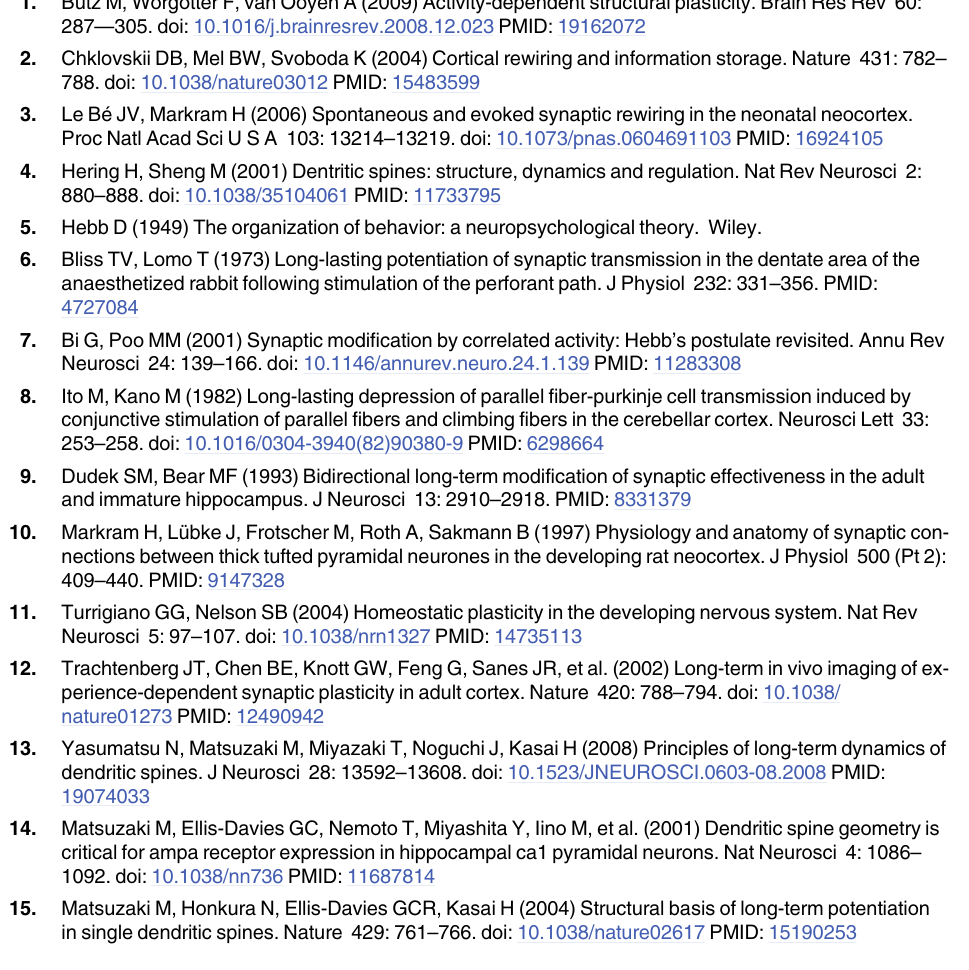
S1 Supporting Table. Learning rules and conditions. For a broad variety of learning rules this table indicates whether the fixed weights fulfil the necessary or the sufficient